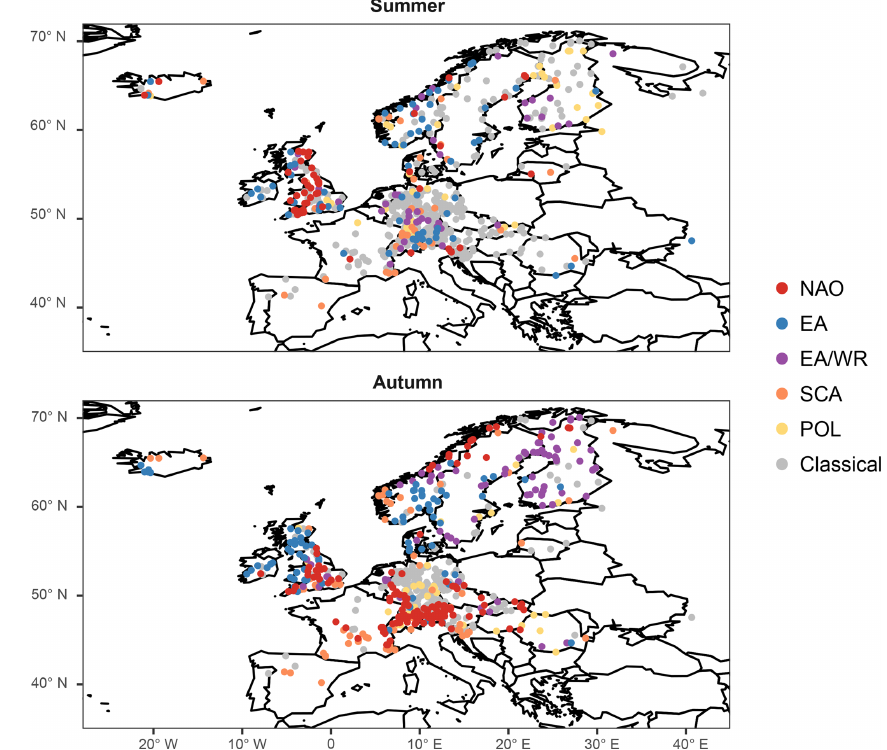
Figure 4. Same as Fig. 3 but for the summer and autumn seasons. Table 3. Seasonal quantiles of the five climate indices: median and the 95th quantile (in parentheses) are provided. Index Winter Spring Summer